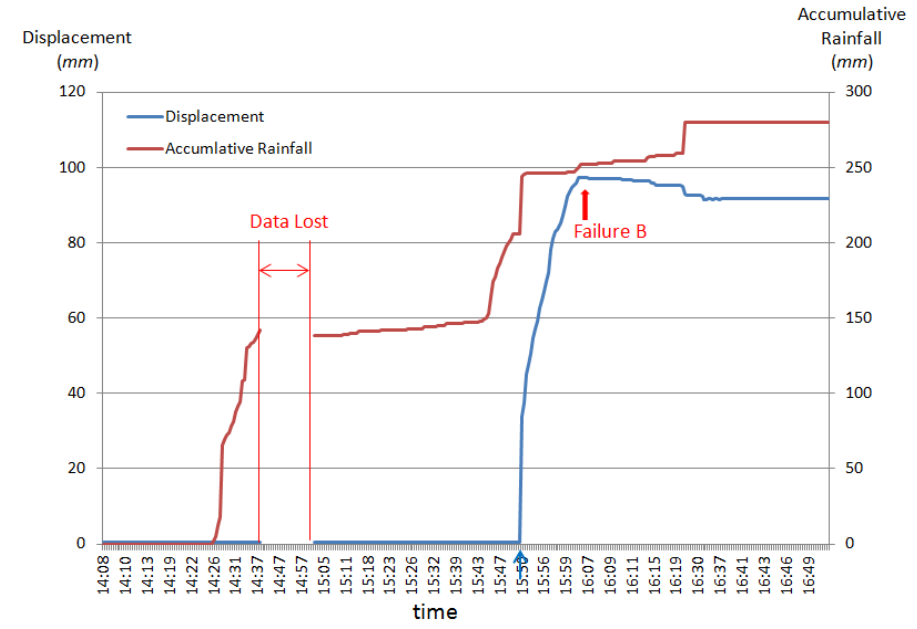
Figure 9. Monitoring data from the rain gauge and the displacement